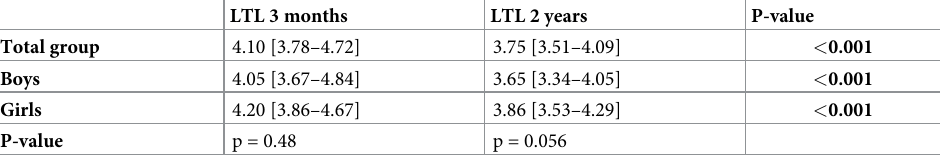
Table 2. LTL (T/S ratio) at age 3 months and 2 years for the total group, boys and